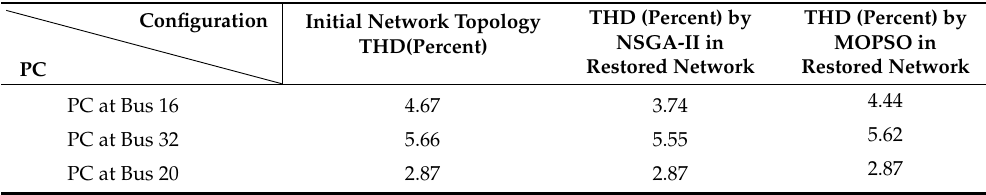
Table 12. Total Harmonic Distortion (THD) values when DC drive load is